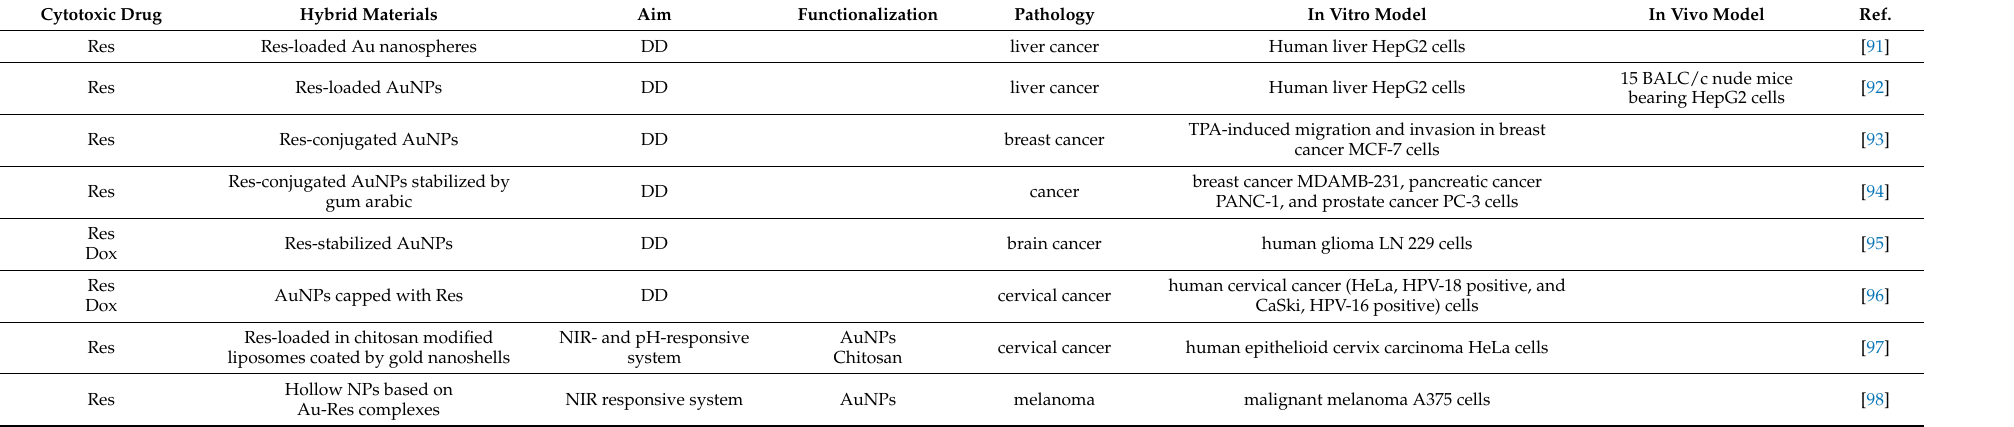
Table 3. Hybrid systems based on AuNPs and Res and projected as potential candidates for the treatment of human cancer.